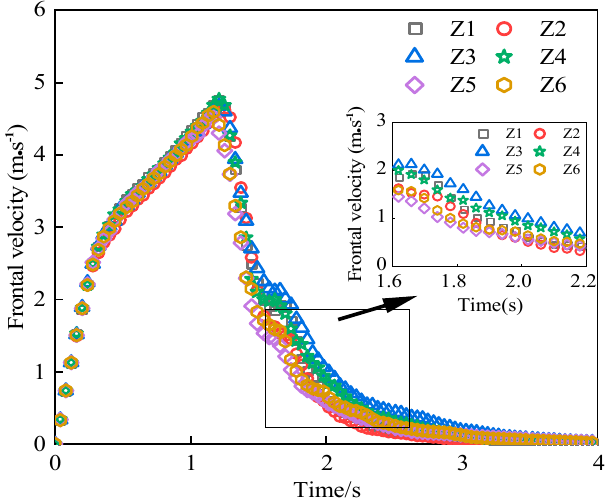
Figure 15. The effect of different baffle groups on the particle tap velocity of debris flows. Effect of Different Baffle Groups and Inter-Baffle Openings on Particle Accumulation Patterns In order to investigate the blocking effeciacy of different inter-baffle openings on the debris flow, the diagrams of the accumulation area of the particle flow after impacting the same type of baffle group but with different inter-baffle opening distances are are drawn as in Figure 16. Figure 16 shows that the accumulation of the debris flow within the three rows of baffles in either of the six cases, whether the distance between baffles is 50 mm or 90 mm. In the cases of the traditional baffle groups, the debris flow iaccumulates just by the row of baffles, and all rows of are made full use of. However, in the cases of the new baffle groups with a opening distance of 90 mm, the debris flow stops and accumulates before reaching the third row of baffles. This means that the new structure of the baffle groups can better block the debris and only tow rows can perfectly achieve the goal. The above phenomenon shows that the six baffle groups with either 50 mm or 90 mm openings can well block the debris flows and the new types of baffles with an opening distance of 90 mm can achieve the function with only the first two rows while the traditional types requires three rows. According to the analysis of the blocking effect of the baffle type on the debris flow in Figure 17, it can be seen that all baffle types have an excellent blocking effect on the flows. In general, the impact distance and width of the accumulation areas varies little between different types of baffle groups. Figure 16a shows that when the opening distance is of 50 mm, the accumulation areas of Z1, Z2, Z3, Z4, Z5, and Z6 are 628,413, 582,935,